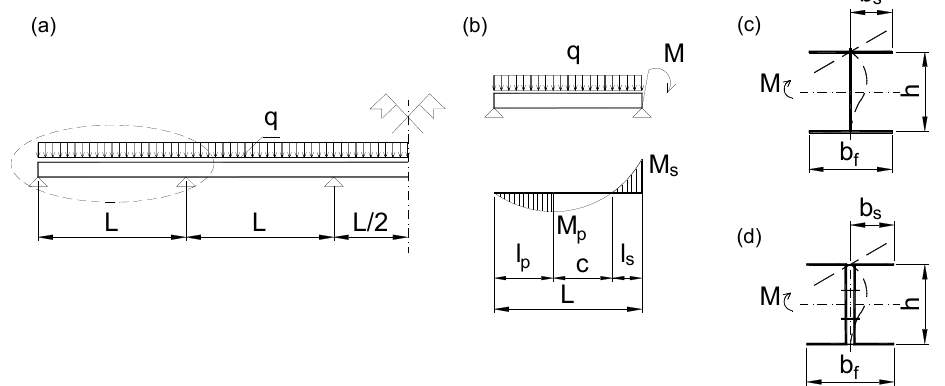
Figure 4. Static scheme of a beam: ( a ) load distribution, ( b ) moment diagram for the first (extreme) span, ( c ) welded I-section, ( d ) 2C compound I-section.